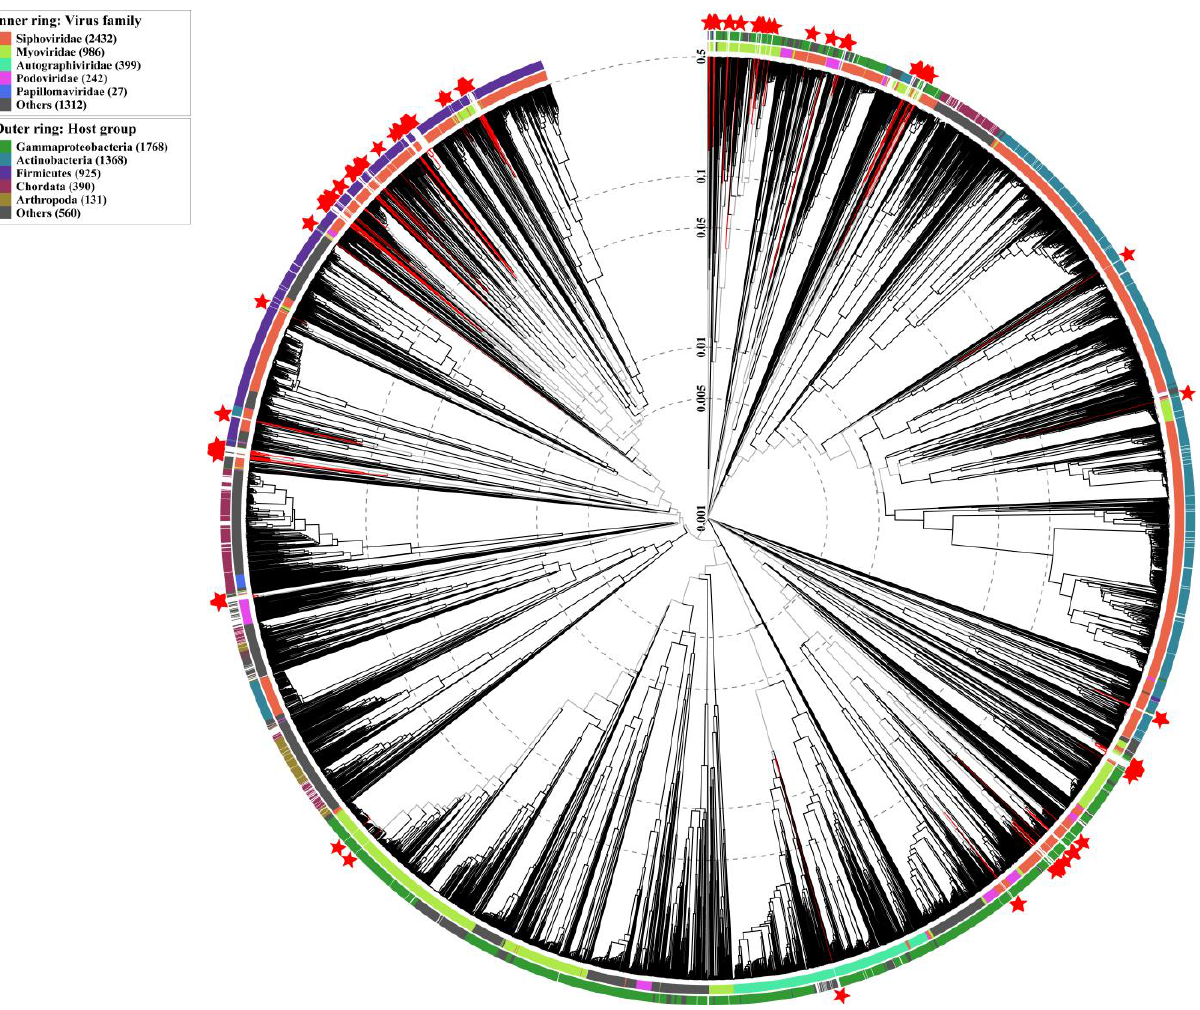
Figure 4. Phylogenetic tree of identified viral genomes. The inner ring represents the taxonomy classification of each clade. The outer ring represents the predicted host of each clade. A clade labeled with a pentagram means that this virus is aligned with a known virus in the IMG/VR database.